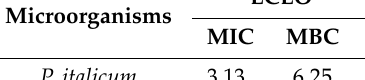
Table 4. Minimum inhibitory concentration (MIC) and minimum bactericidal concentration (MBC), in mg mL − 1 , of LCEO, against three fungi in postharvest citrus.